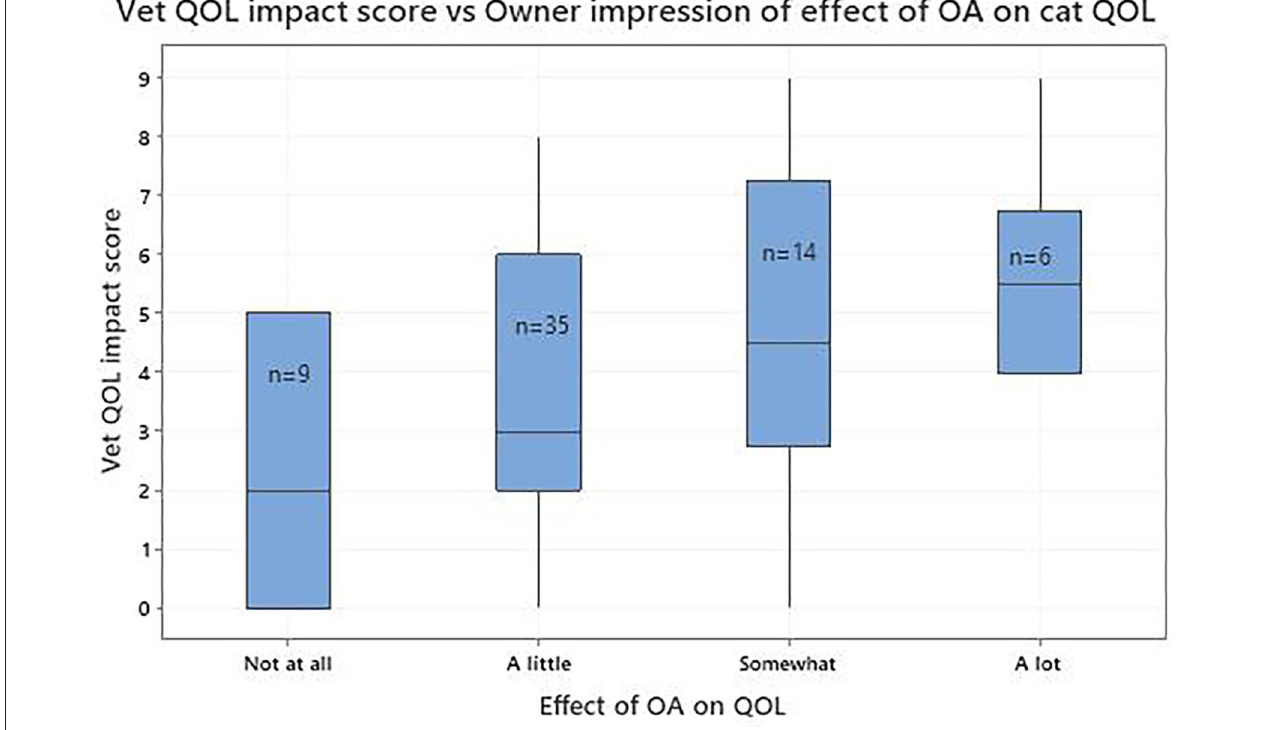
FIGURE 5 | Vet-assessed quality of life (QOL) impact score (scale 0–10, where 0 is no impact and 10 is maximum possible impact) categorised by the owner’s impression of QOL